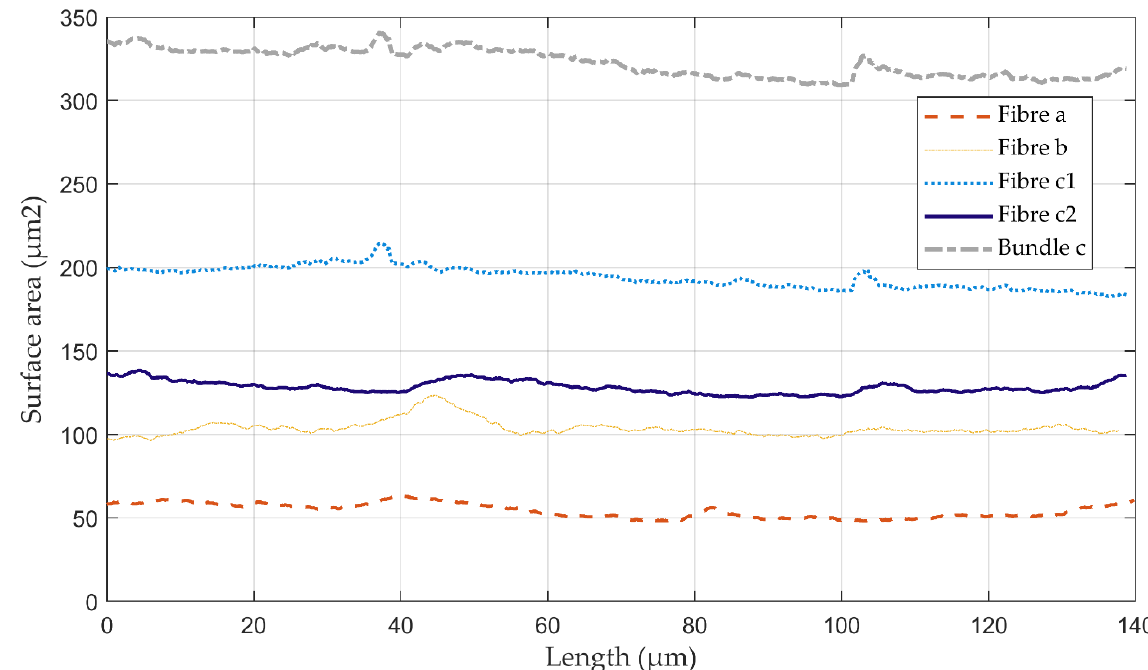
Figure 8. Evolution of the external surface area along two flax fibres “a” and “b” and a bundle “c” composed of two fibres “c1” and “c2”, calculated from X-ray microtomography data.